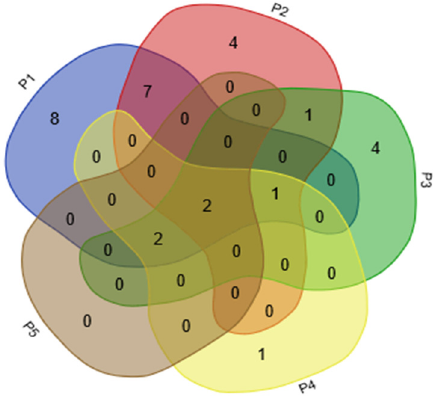
Figure 5. Total emission amounts of VOCs emitted from L. caudata flowers and their isolated floral parts.